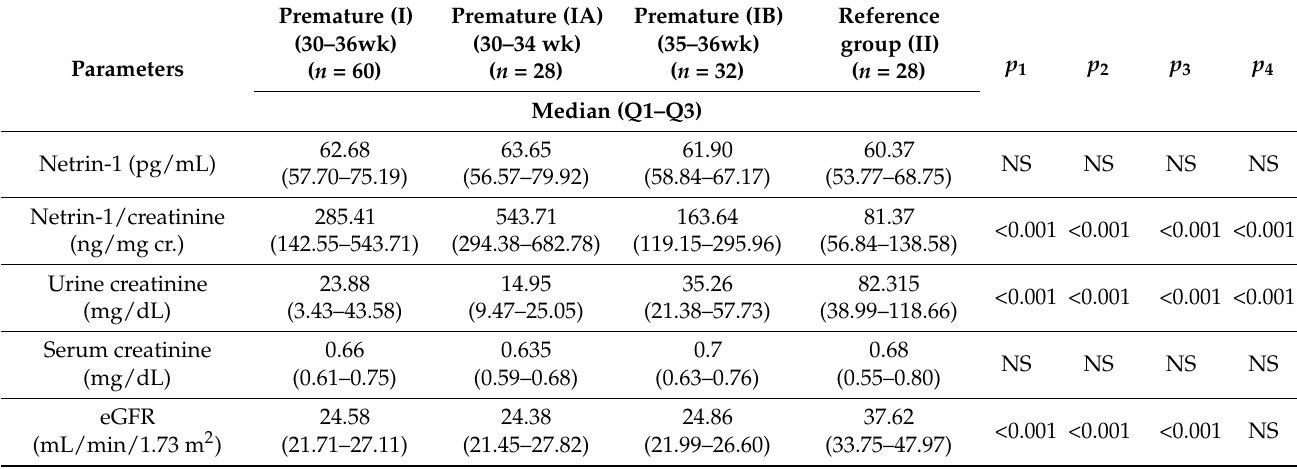
Table 3. Median values and interquartile range (IQR) of examined parameters in premature newborns and the reference group.